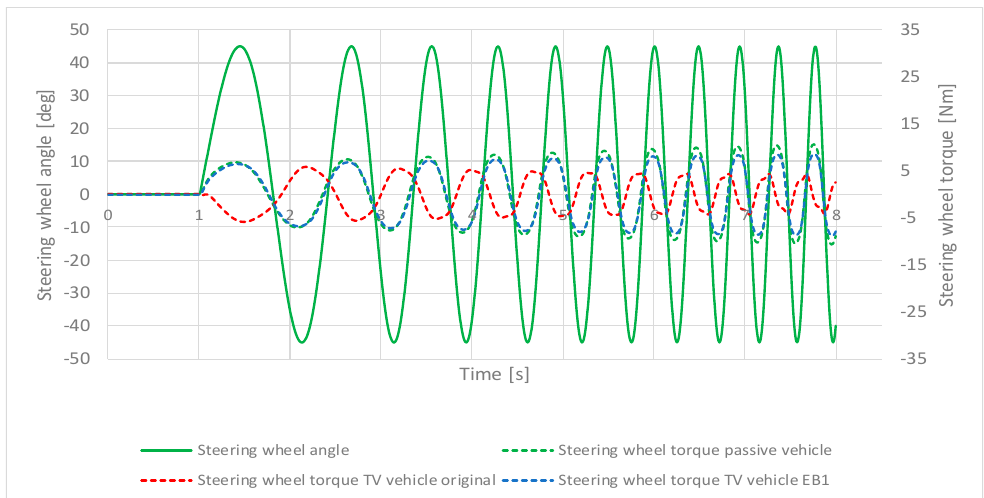
Figure 17. The EB1 sine steer (blue) compared with TV original (red) and passive vehicle (green).